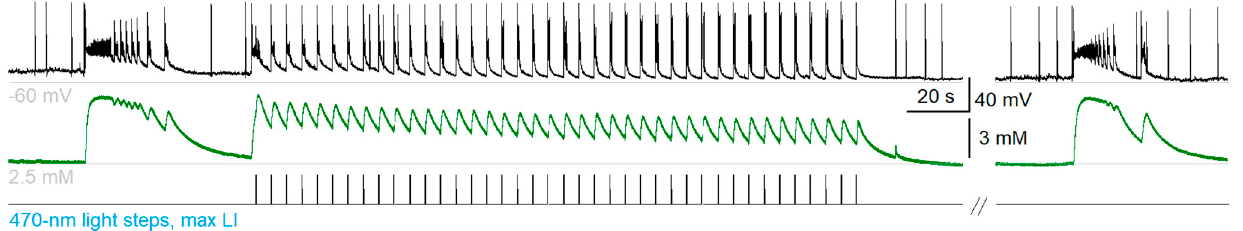
Figure 9. Dynamics of the extracellular potassium ion concentration before, during, and after LFLS recorded simultaneously with the spiking activity of a principal cell in the entorhinal cortex in the in vitro 4-AP model .